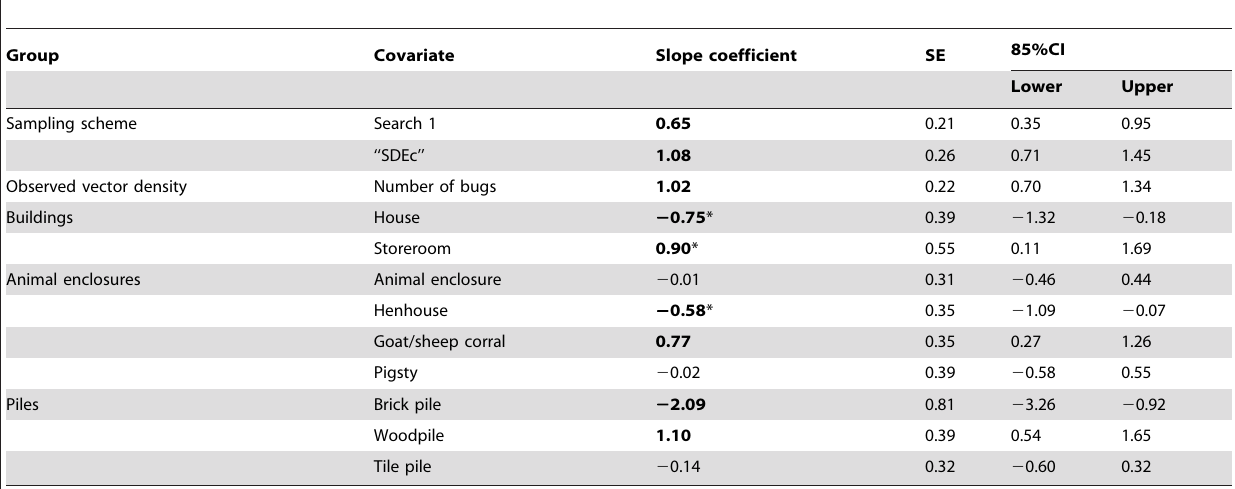
Table 5. Model-averaged, adjusted slope coefficient estimates for detection covariates appearing in the subset of models with non-zero Akaike weights (see Table